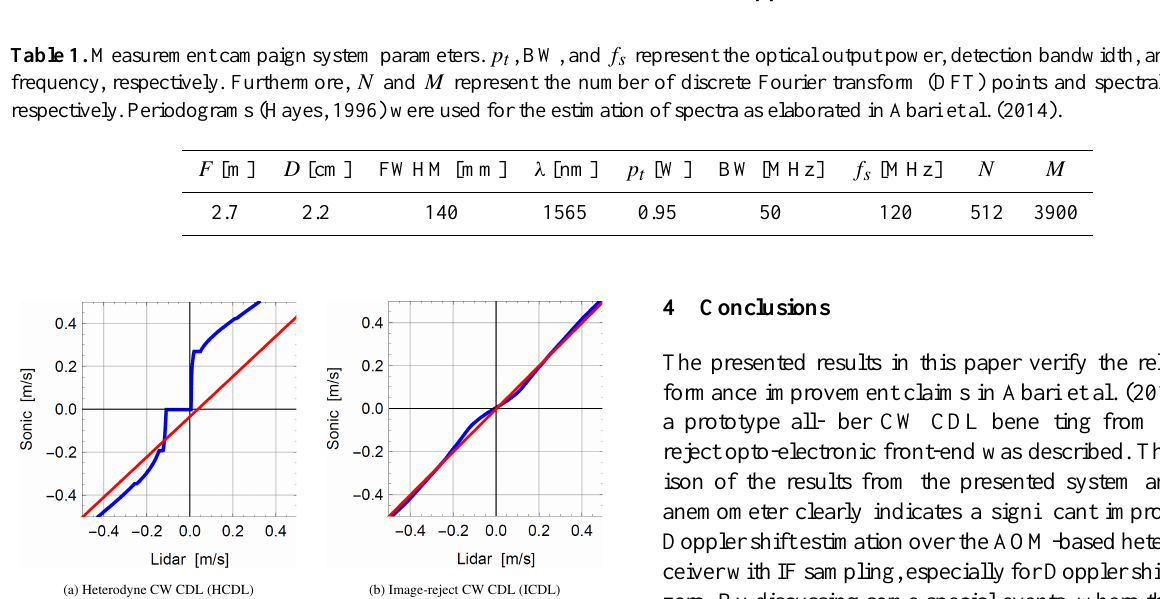
Figure 7. The estimated median velocities sorted in ascending order and stacked against the sonic anemometer (blue). The red line is a linear fit to the blue curve which extends to several ms − 1 in both directions. For an ideal lidar (and sonic anemometer) the blue curve would be a one-to-one